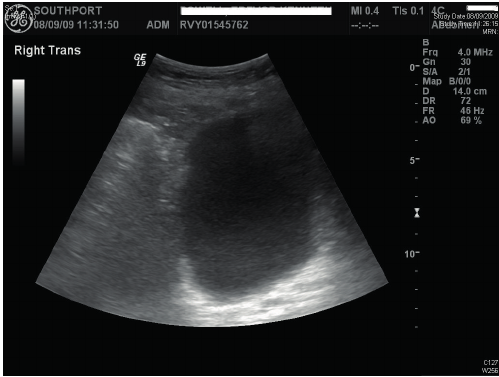
Figure 3: Ultrasound showed trabeculated bladder outline. There was no bladder mass.